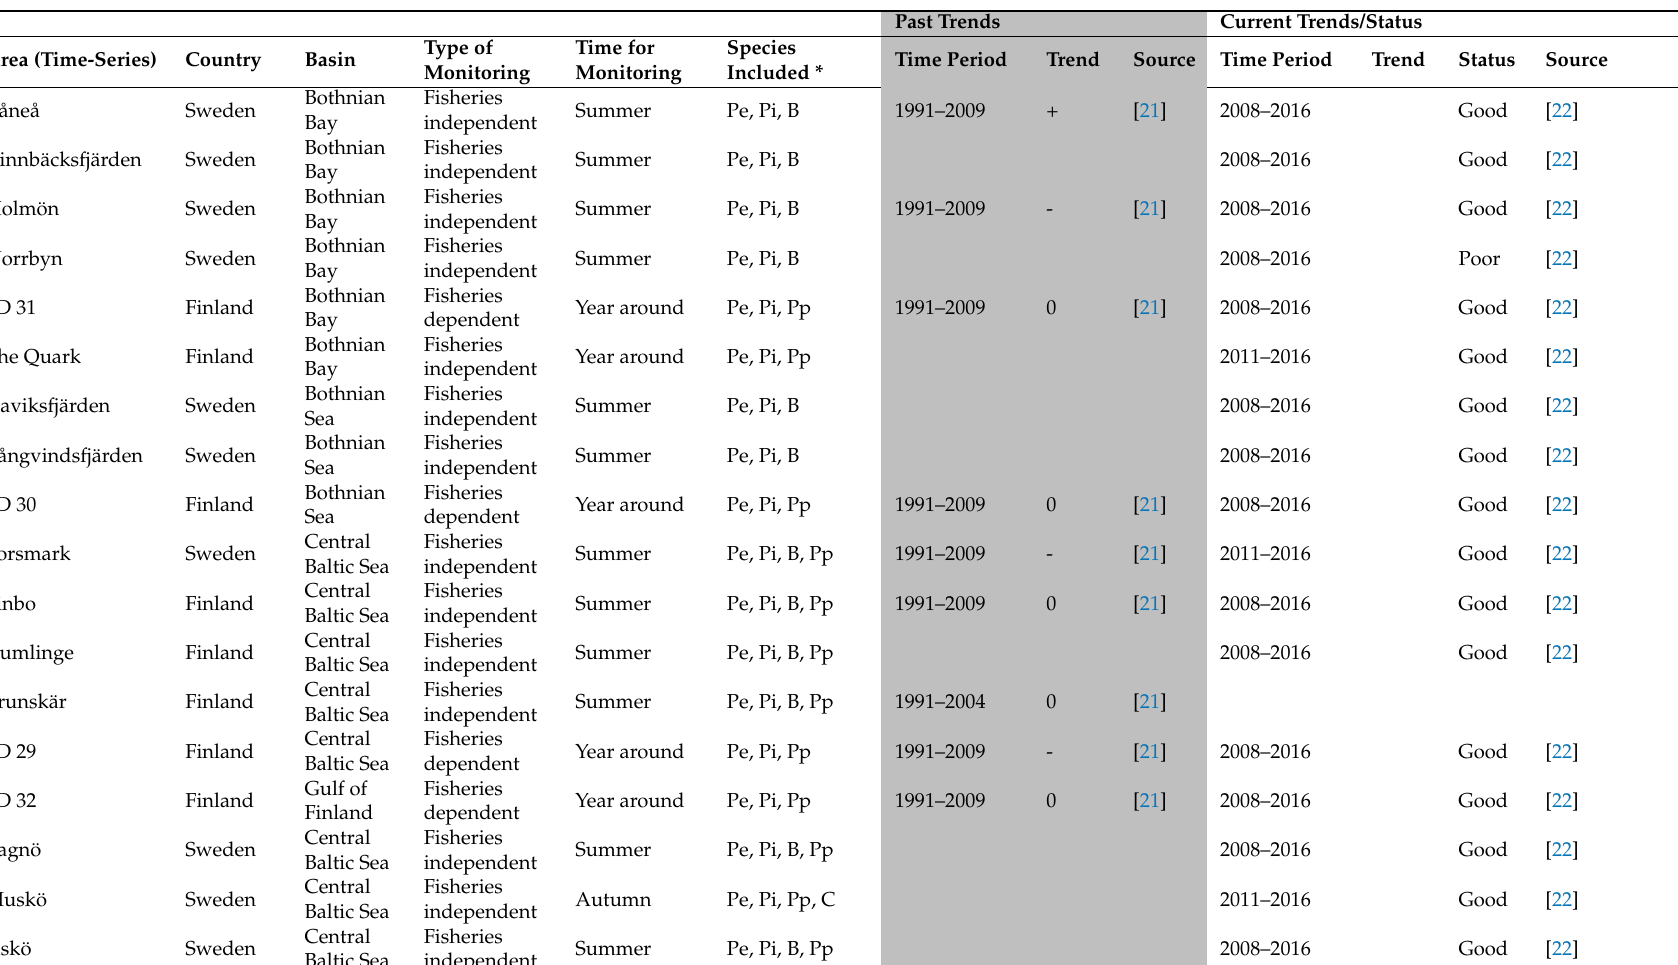
Table 1. Overview of the data and time-series used to assess past (data until the 2000s, grey columns) and current (data until the 2010s white columns) trends and status for coastal predatory fish. For the column “Species included”, Pe = perch, Pi = pike, B = burbot, Pp = pikeperch, C = cod and T = turbot. The columns “Source” refers to reference number. * The predatory fish abundance was calculated as the summed average abundance of included